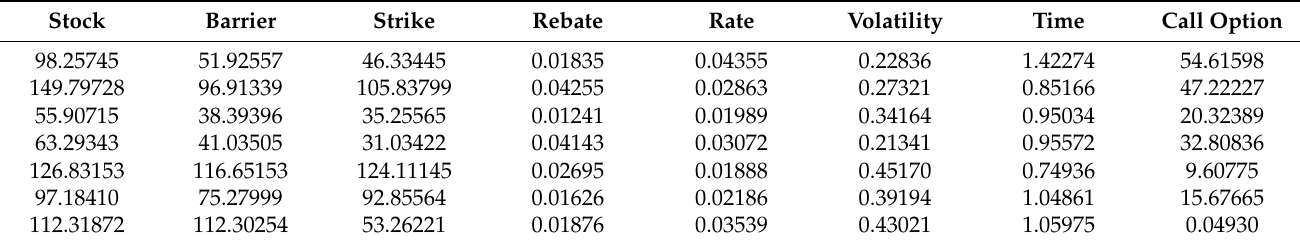
Table 4. Sample training data for rebate barrier option pricing